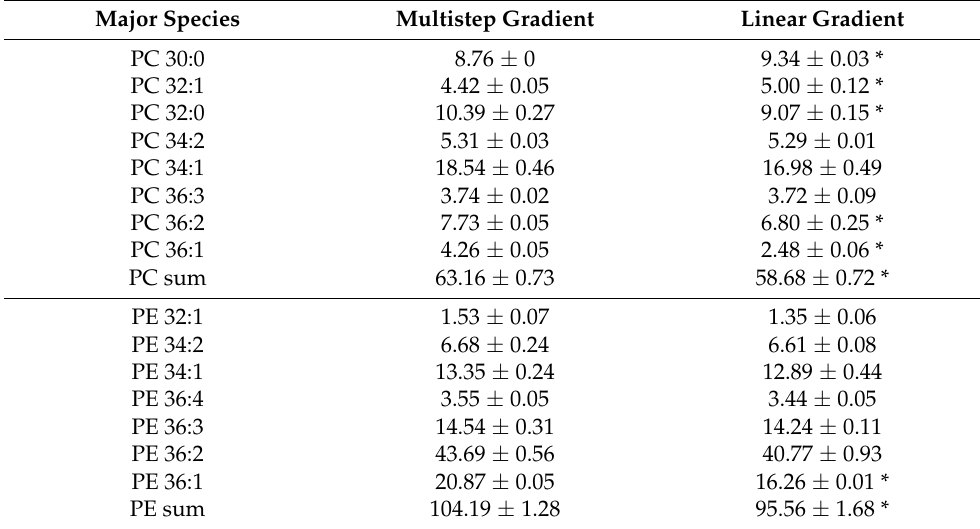
Multistep Gradient Linear